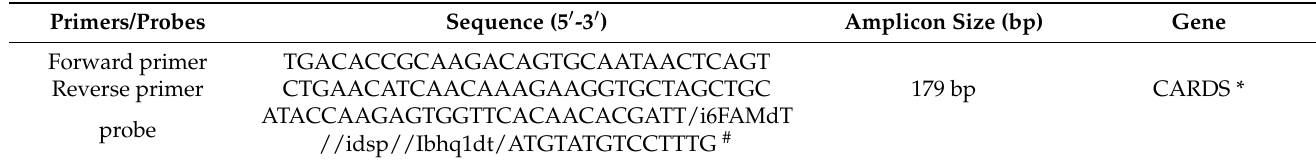
Table 1. The sequence of primers and probes for M. pneumoniae RPA